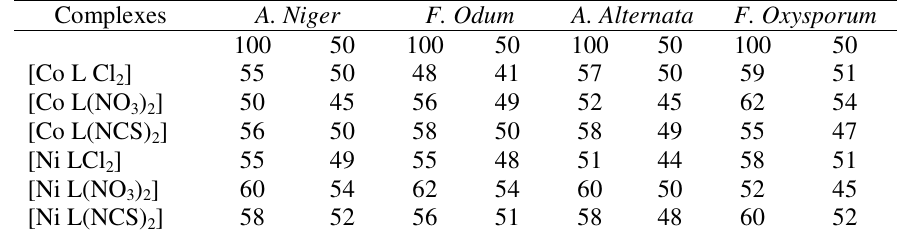
Table 4 . Antifungal screening data of the Co(II) and Ni(II) complexes fungal inhibition % (conc. in